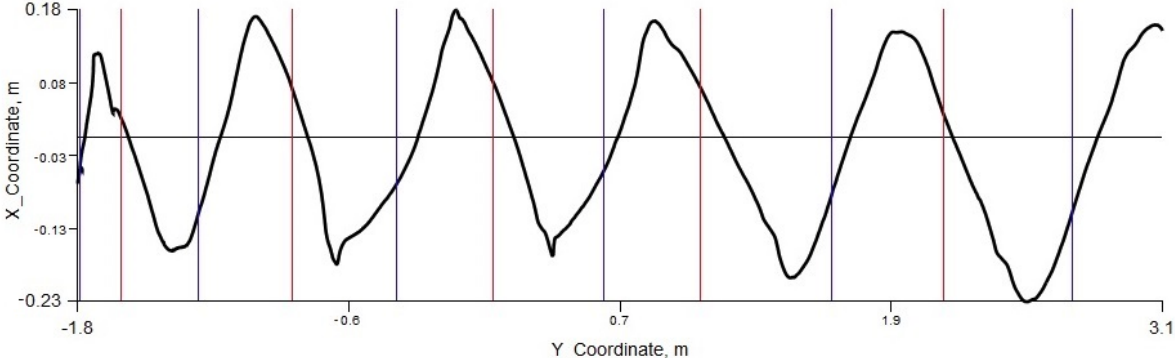
Figure 4. Typical motion path of 10th spinous process of vertebra marker. Vertically—motions to the left (up) and to the right (down), scale in meters. Horizontally—motions from the left to the right (scale in meters).